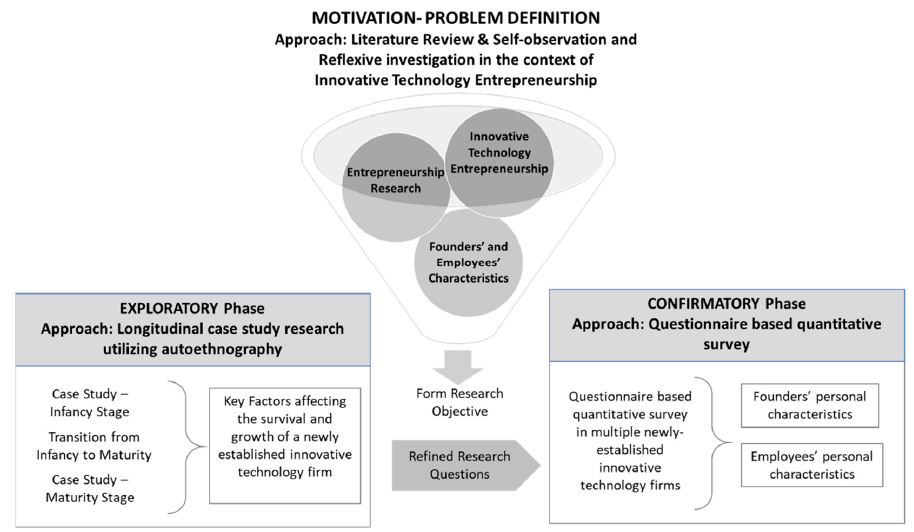
Figure 1. Research Approach.